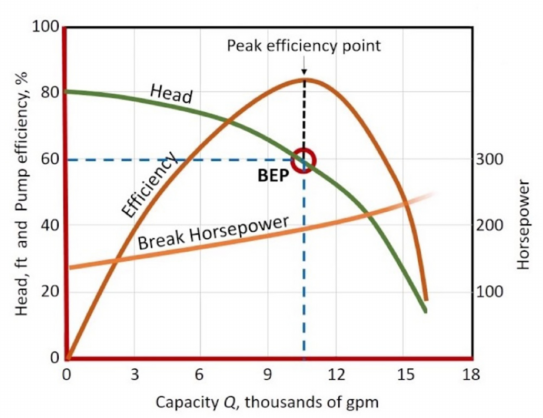
Figure 1. The pumps’ hydraulic and efficiency curves [28].